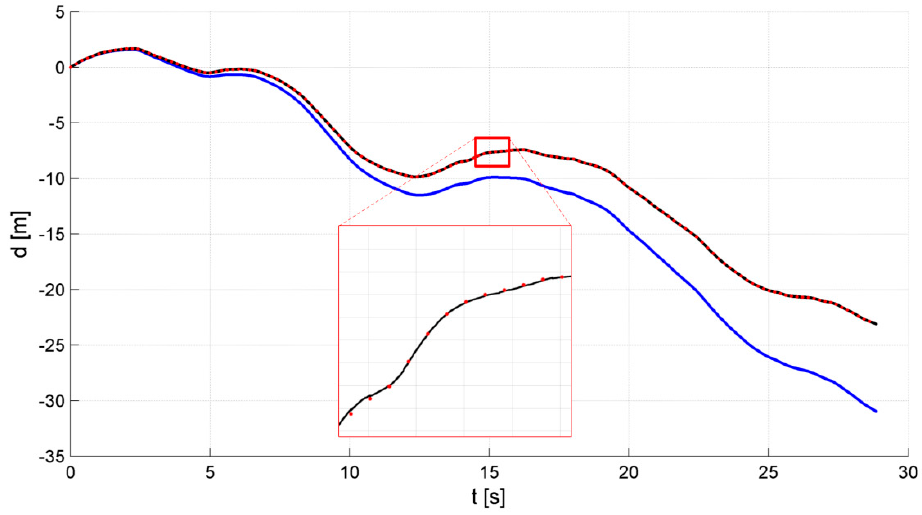
Figure 6. Position along vertical (down) axis: black—INS/GPS, red—GPS, blue—INS.